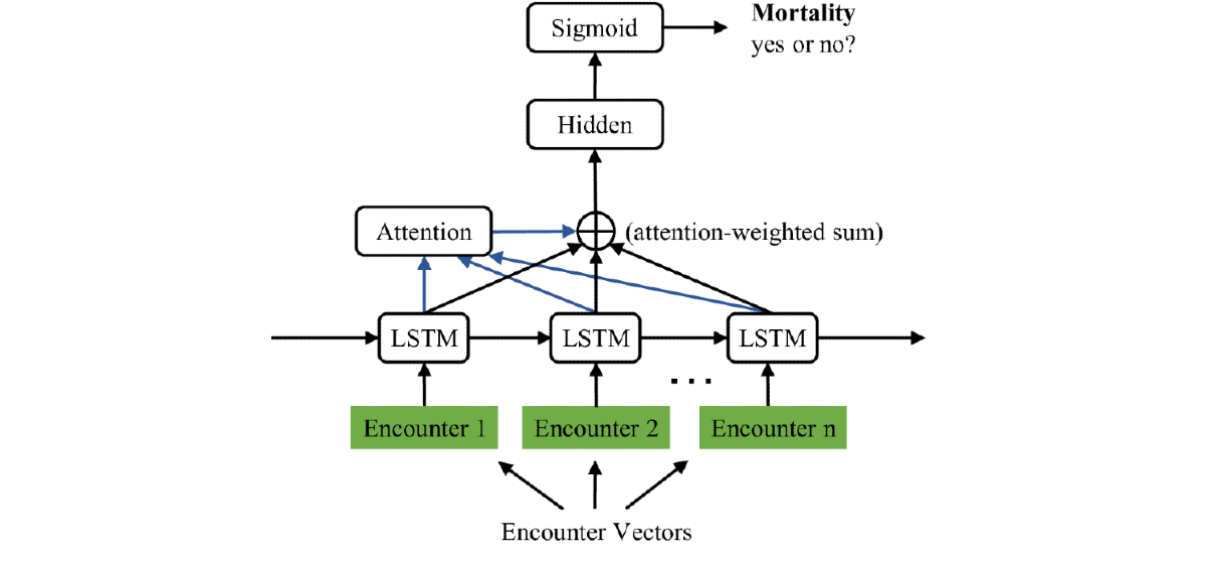
Figure 1. Our model architecture. LSTM: long short-term